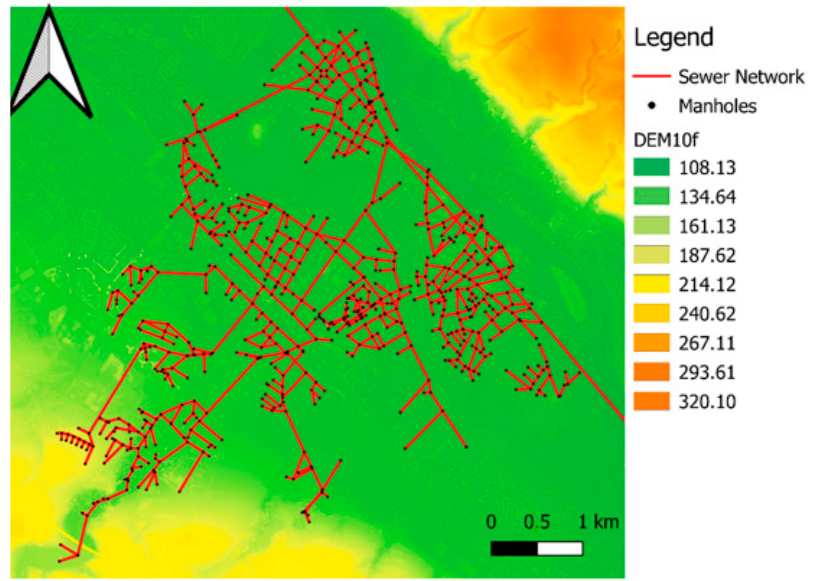
Figure 1. Digital surface model of study area with urban drainage network and manholes of study area in the Lockwitzbach subcatchment.